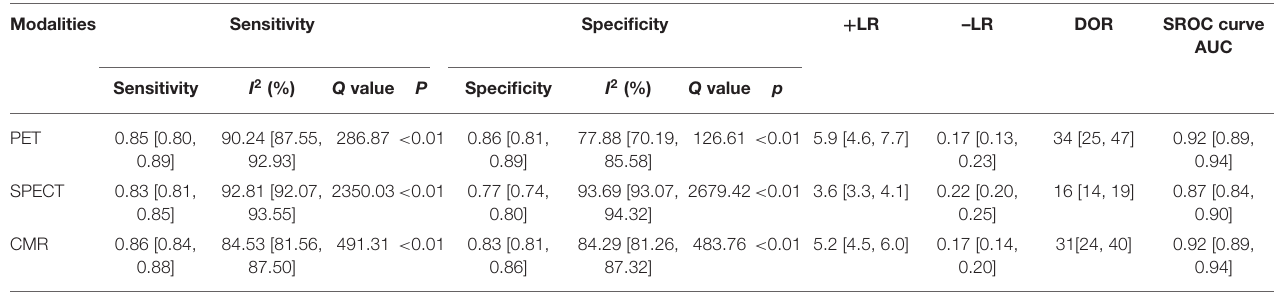
TABLE 1 | Diagnostic performance of MPI